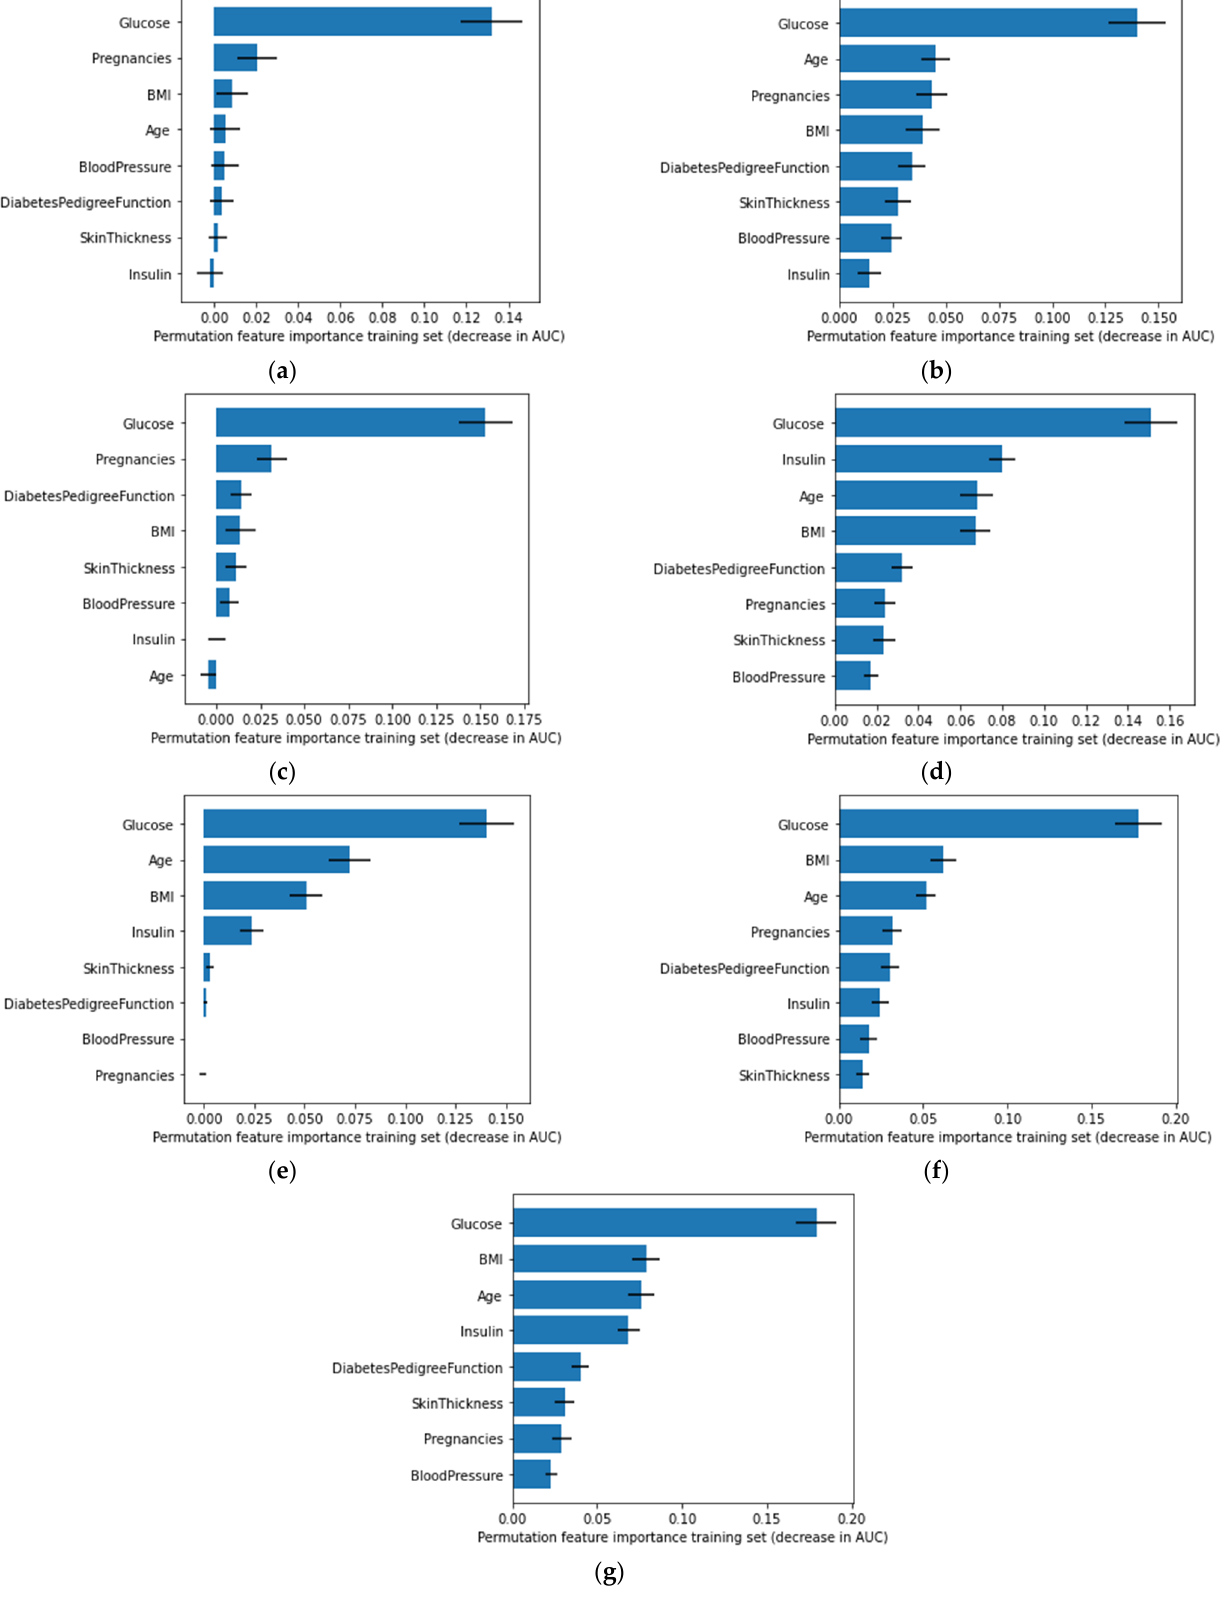
Figure 11. Permutation feature importance of ( a ) ANN, ( b ) SVM, ( c ) LR, ( d ) RF, ( e ) ADA, ( f ) XGB, and ( g ) Voting classifier.